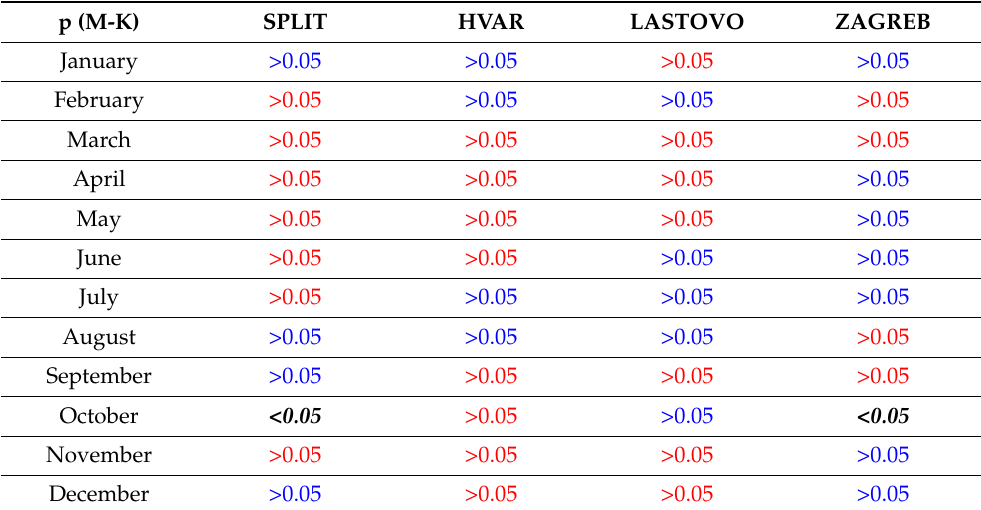
Table 7. Matrix with the results of the probability of the Mann–Kendall test, p (M-K). p (M-K) SPLIT HVAR LASTOVO